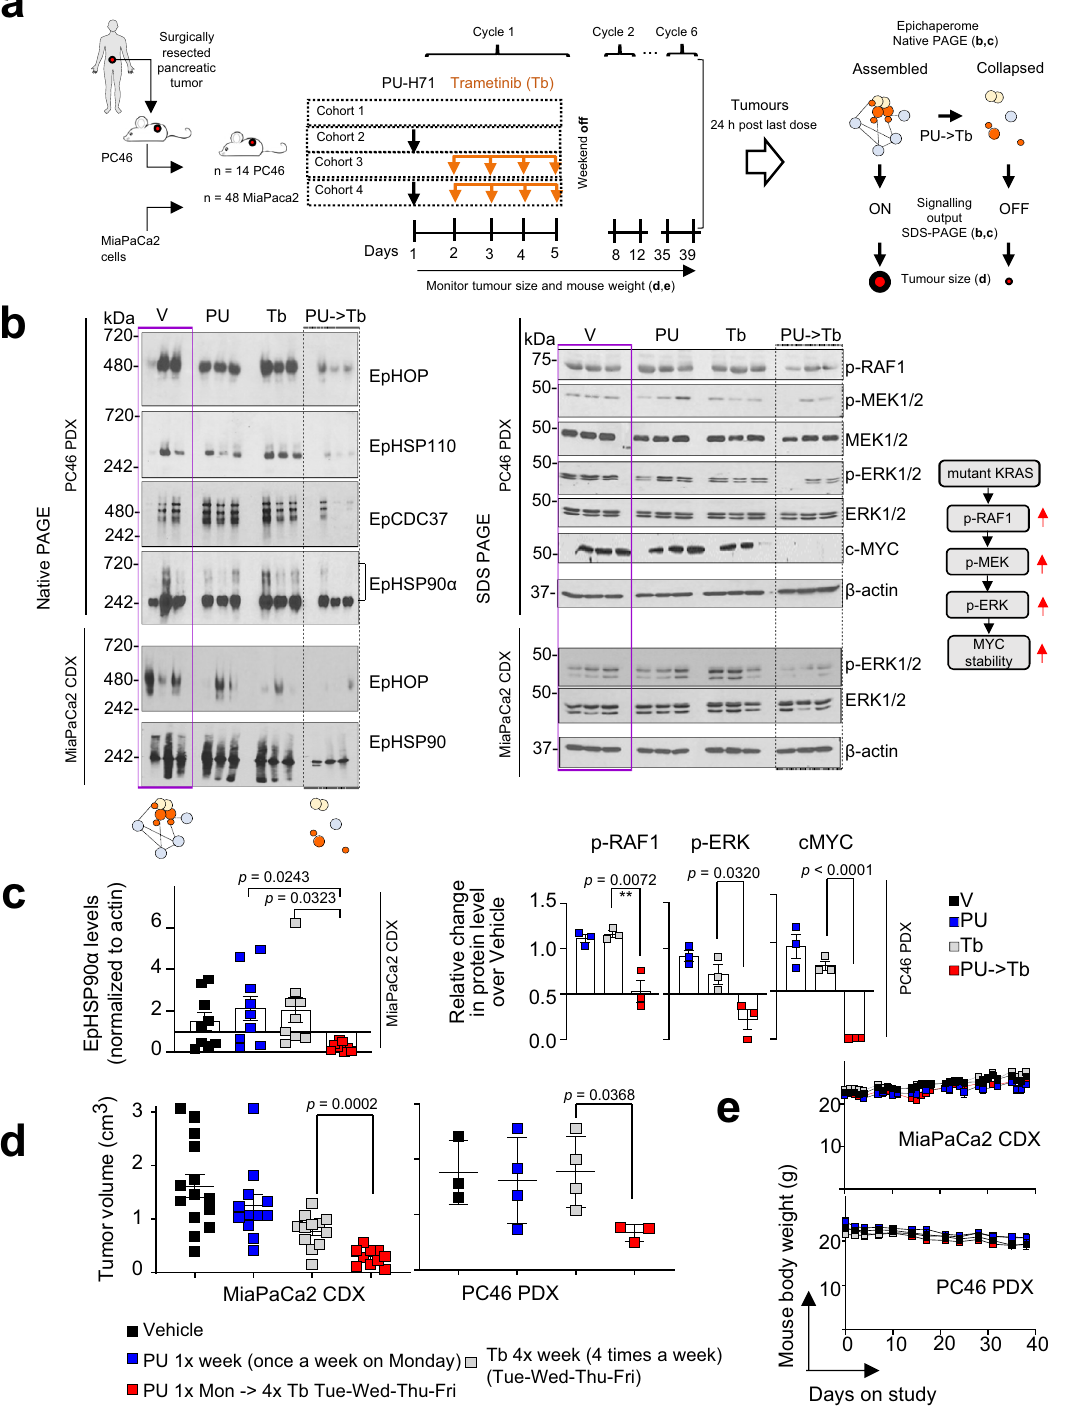
Fig. 8 Trametinib becomes effective in Ras-driven pancreatic tumours when these are forced into a temporary state of interactome hyperconnectivity. a Schematic of the experimental design and the expected outcome of the PU-induced interactome hyperconnectivity. b Native-PAGE shows epichaperome levels and SDS-PAGE signalling activity in individual tumours ( n = 3 from each cohort as in ( a )). See also Supplementary Fig. 5. c Epichaperome levels in MiaPaCa2 tumours and signalling activity in PDX PC46 tumours. Error bars mean ± SEM; unpaired two-tailed t test. d The anti-tumour activity of Trametinib (Tb) when tumours are forced into a state of interactome hyperconnectivity by PU-H71 (PU) given on Monday, each week. Tb is administered then daily, 24 h after PU. PU- > Tb, PU (75 mg kg − 1 ) given on the fi rst day followed 24h later by Tb (1 mg kg − 1 ) given on the next four consecutive days; Vehicle (Control); PU-H71 (75 mg kg − 1 , PU) given once per week; Trametinib (1 mg kg − 1 , Tb) given on four consecutive days. Pooled from 2 independent experiment, n = 14 and 3 mice for Vehicle; 12 and 4 mice for PU; 12 and 4 mice for Tb; 10 and 3 mice for PU- > Tb, in MiaPaCa2 CDX and PC46 PDX tumours, respectively. Error bars mean ± SEM; unpaired two-tailed t-test. e Body weight of each cohort as in ( a ). Graph, mean ±